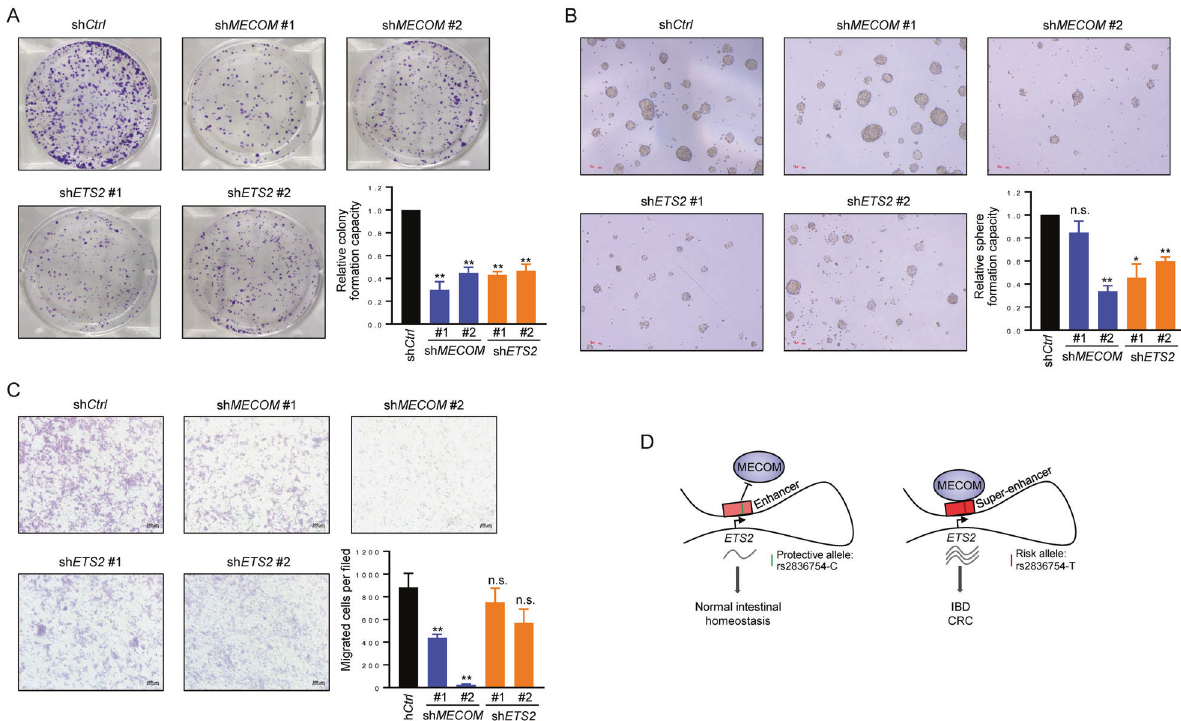
Fig. 5 MECOM and ETS2 are required for sustaining the oncogenic capacity of CRC cells. A Representative photos and quanti fi cation results of monolayer colony-formation assay for HCT15 cells stably expressing shRNAs targeting MECOM , ETS2 or a non-targeting shRNA. B Representative photos and quanti fi cation results of sphere-formation assay for HT29 cells stably expressing shRNAs targeting MECOM , ETS2 or a non-targeting shRNA. C Representative photos and quanti fi cation results of transwell migration assay for Lovo cells stably expressing shRNAs targeting MECOM , ETS2 or a non-targeting shRNA. * p < 0.05; ** p < 0.01; n.s. non-signi fi cant. D Schematic diagram showing the mechanism underlying the activation of oncogenic ETS2 by a distal SE in IBD and CRC. Please refer to the text for